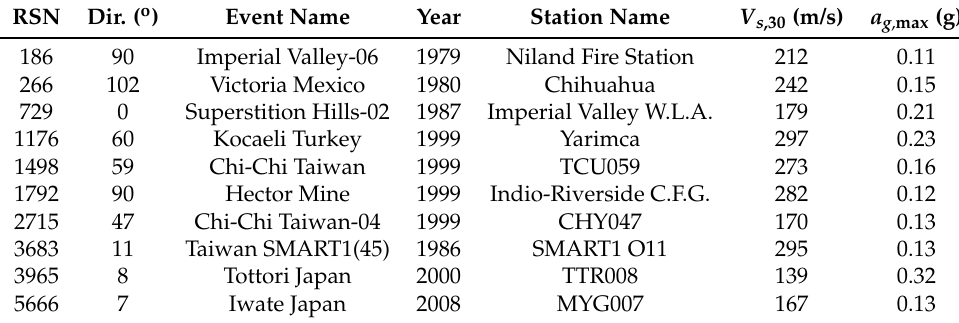
Table 6. Information about the accelerograms used in this study. Source: [40]. RSN Dir. ( o